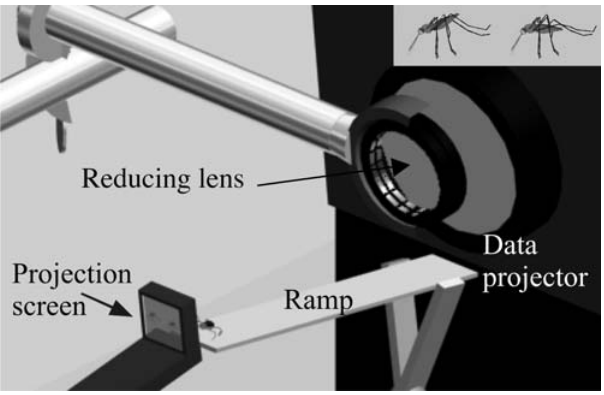
Figure 1. Apparatus for virtual-prey testing. Spider (not to scale) at top of inclined metal ramp, oriented toward one of two side-by-side virtual mosquitoes. Virtual mosquitoes on small screen (projection screen, see enlarged inset in top right corner) positioned in front of higher end of ramp. Images pass from projector lens (connected to computer; main body of data projector and computer not shown) through second lens (for reducing image size) on to screen. Observer point of view: about 150 degrees from the direct light path from the projector through the projection screen; slightly behind the projection screen at a height of approximately 45 degrees. Inset: virtual mosquitoes in Anopheles resting posture (left) and in non- Anopheles resting posture (right).